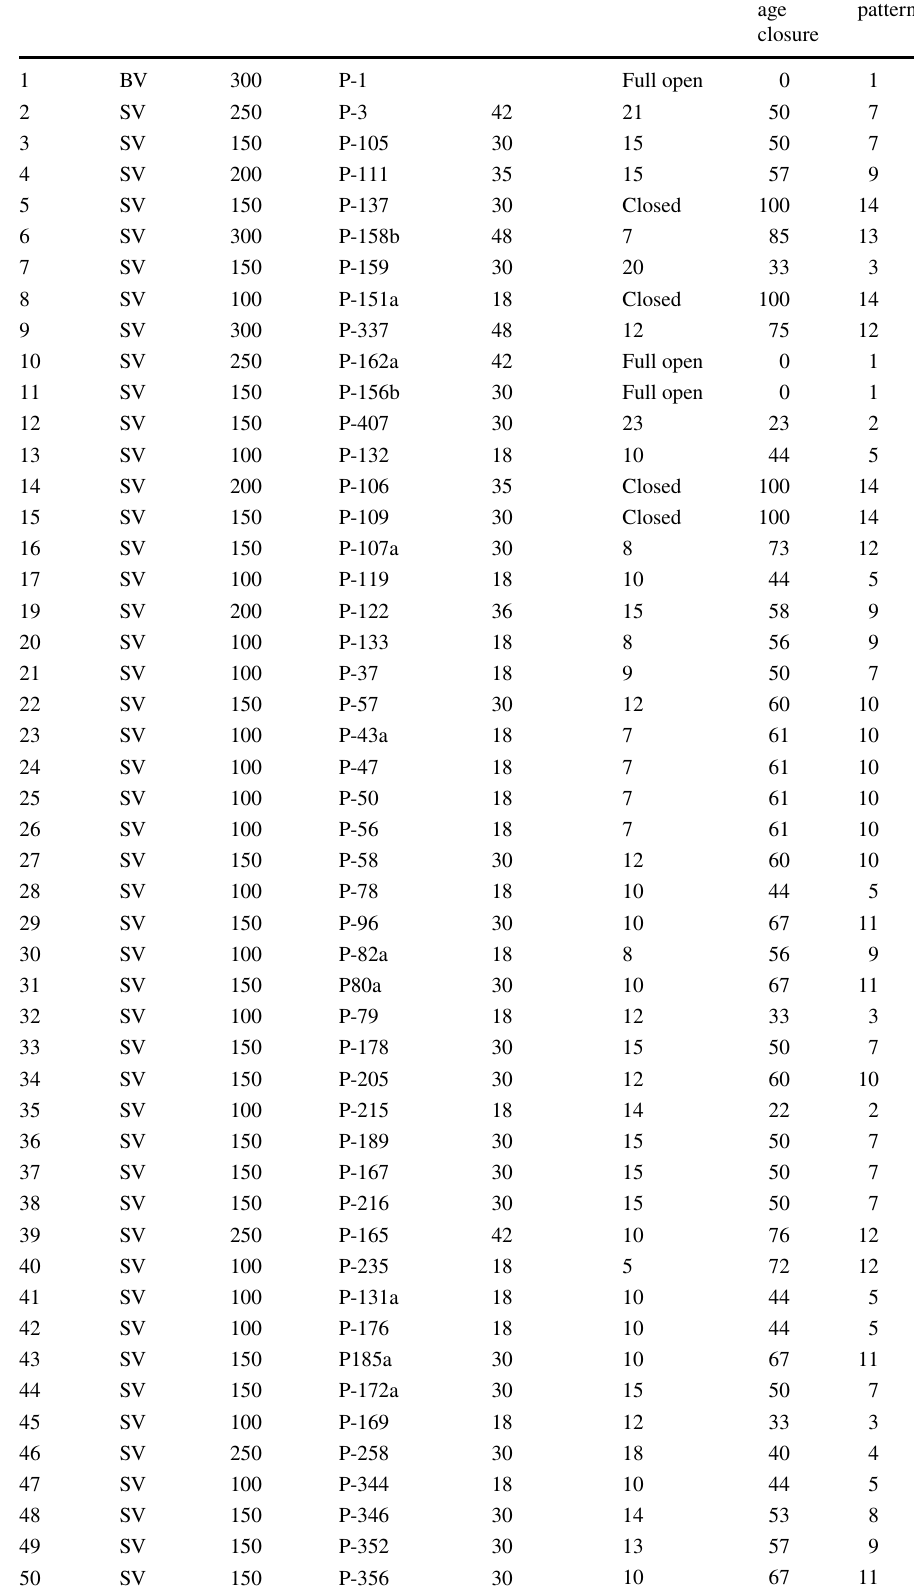
operational status during the